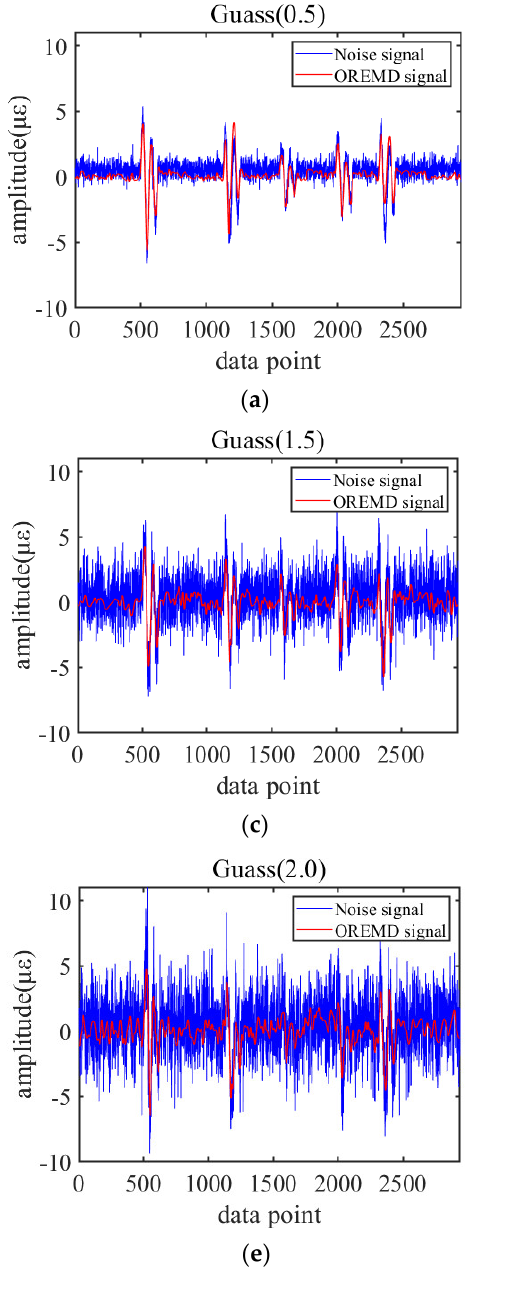
Table 5. Sifting effect of different signal sources.